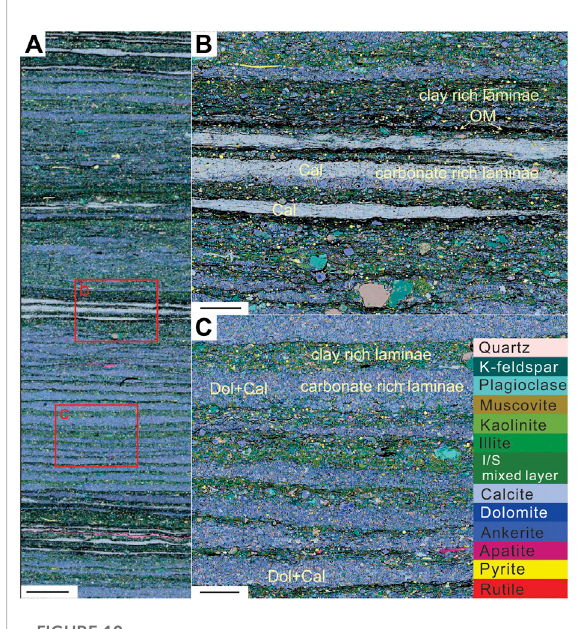
FIGURE 10 Representative petrographic images of laminated Eocene black shale in Bohai Bay Basin. Scale bars represent 500 μ m in (A) and 100 μ m in (B,C) . (A) Overview image of laminated shale; (B) calcite laminae associated with OM rich laminae; (C) OM- poor clay laminae with dolomitic laminae. Laminae with different mineralogy host distinct organic geochemical features which cannot be recognized from bulk